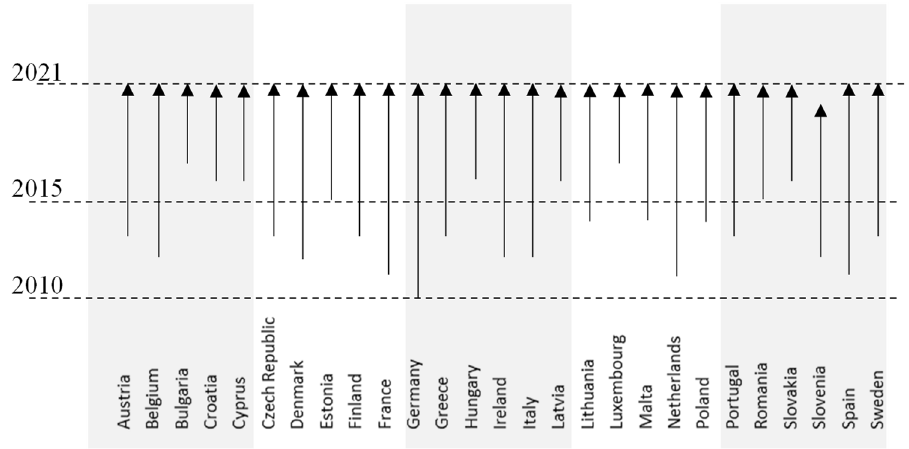
Figure 4. Year of existing studies in the literature by country.